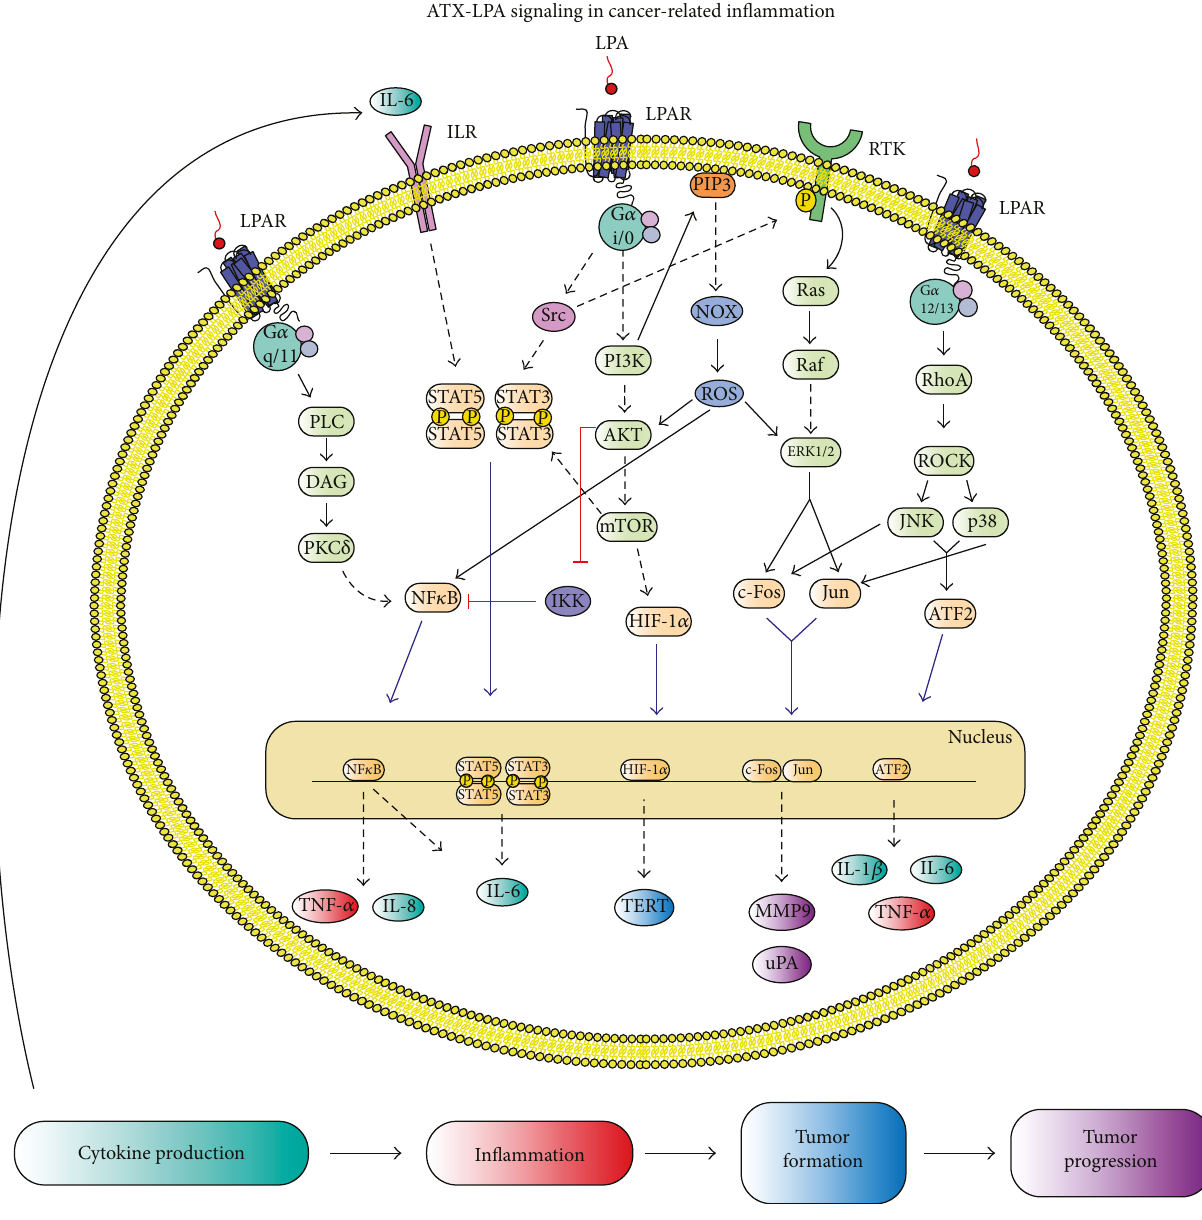
Figure 3: ATX-LPA axis promotes cancer-related in fl ammation. In CRI, LPA acts on its receptors via G α induces NF κ B activation through PKC δ promoting TNF- α , IL-8, and IL-6 production. G α culminating in NF κ B and HIF-1 α translocation to the nucleus. HIF-1 α induces the transcription of TERT enabling